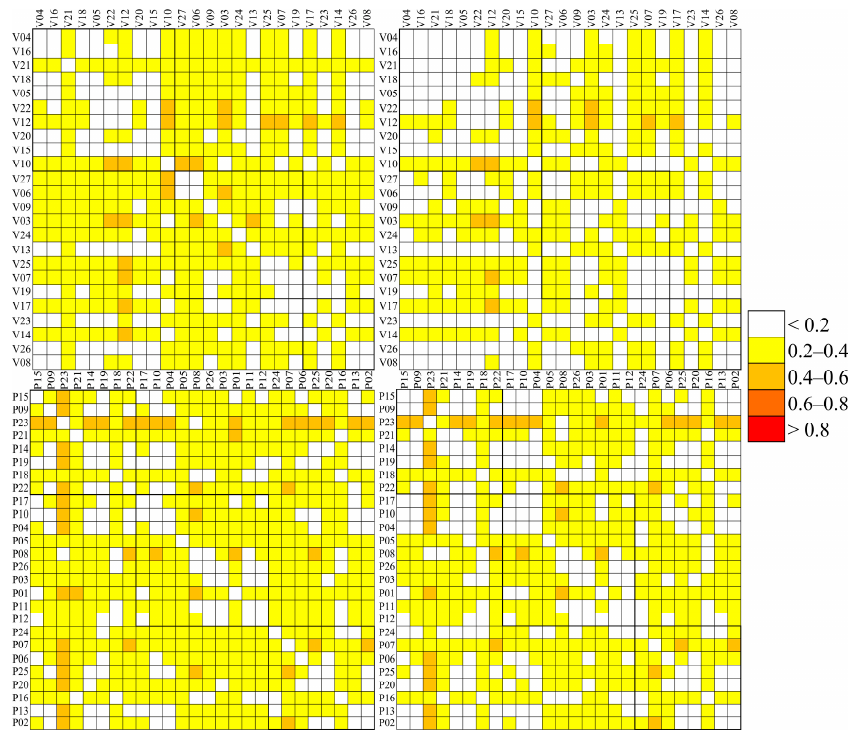
Figure 6. Top: COD between Speck PM monitors calculated from hourly ( left ) and daily ( right ) PM averages from bias and LOD corrected data from the first campaign, bottom: the same for the second campaign.